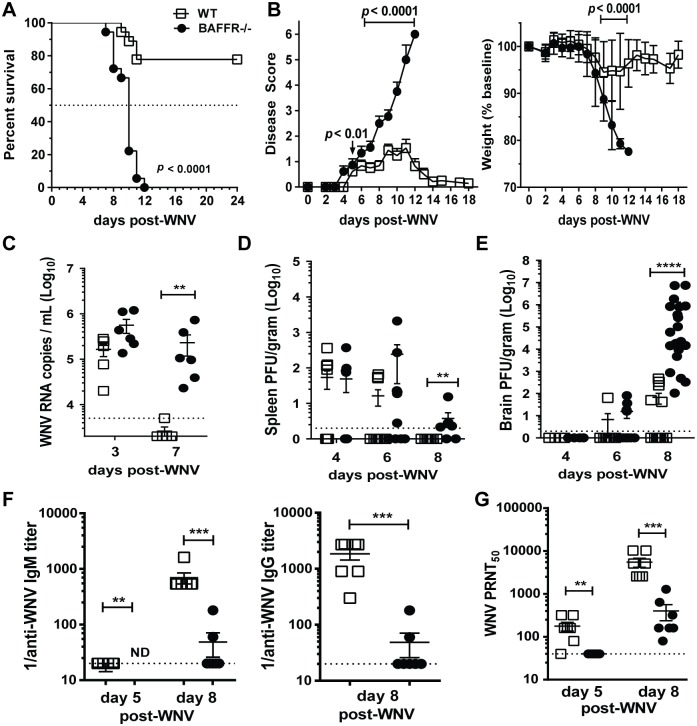
BAFFR-/- mice have increased mortality, increased viral titers, and reduced and delayed WNV-specific and neutralizing Ab responses after WNV infection.Adult C57BL/6 WT mice (white squares) and BAFFR-/- mice (black circles) were inoculated s.c. with 102 PFU of WNV (strain Texas 2002) and monitored daily for survival (A) and clinical signs of disease (B); Sera (C) and tissues (D and E) were harvested at the indicated day post-WNV infection; and virus-specific Abs (F) or nAbs responses (G) in sera were measured at the indicated time points post-infection. A, Statistics were performed using a log-rank test for significance comparing the percentage of surviving WT mice to that of BAFFR-/- mice. B, Clinical course of disease (left panel). Error bars represent variance of clinical scores. Weights (right panel) are reported as % of the mouse weight before infection. Significance was determined with the multiple t test Holm-Sidak method, significant p values are shown. A and B, graphs summarize data from four independent experiments (N = 18). Viral titers in sera were quantified using real-time qPCR (C), and were determined in tissues using a standard plaque assay (D, and E). Graphs show PFU of virus per gram of tissue or copies of viral RNA per ml serum. (C-E), Graphs summarize data from two independent experiments; C, N = 6; D and E, N = 6–15. The dotted lines represent the limit of detection. Statistics were determined by two-tailed Mann-Whitney t test, ** p<0.01, *** p<0.001. (F) Anti-WNV E -IgM (left panel) and -IgG (right panel) were measured by ELISA, each symbol shows relative titers from an individual mouse. ND, not detected. (G) nAb titers were determined by a PRNT assay, with 50% virus inhibitory capacity. In F and G, data show one representative experiment (N = 7) out of more than three independent infections with at least four mice per group per time point. The dotted lines represent the limit of detection. Statistics were determined by two-tailed Mann-Whitney t test, ** p<0.01, *** p<0.001.